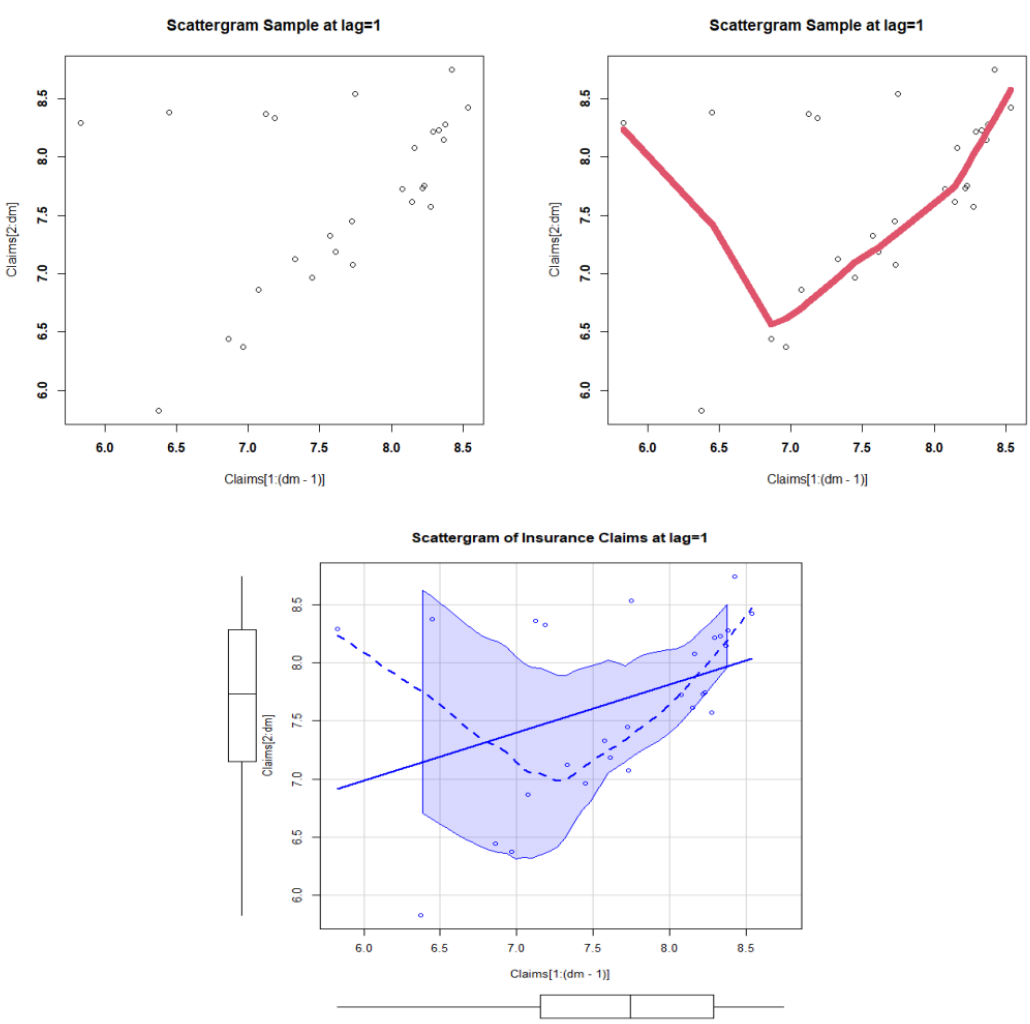
Figure 10. The Figure 10. The scattergrams.